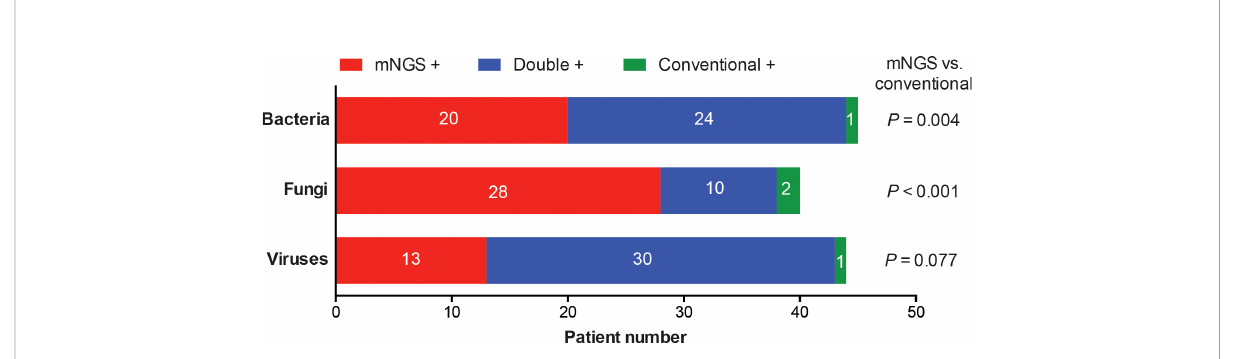
FIGURE 2 Categorization of infection events detected by mNGS and conventional methods alone or simultaneously. Detection rates of bacteria, fungi or viruses were compared between mNGS and conventional